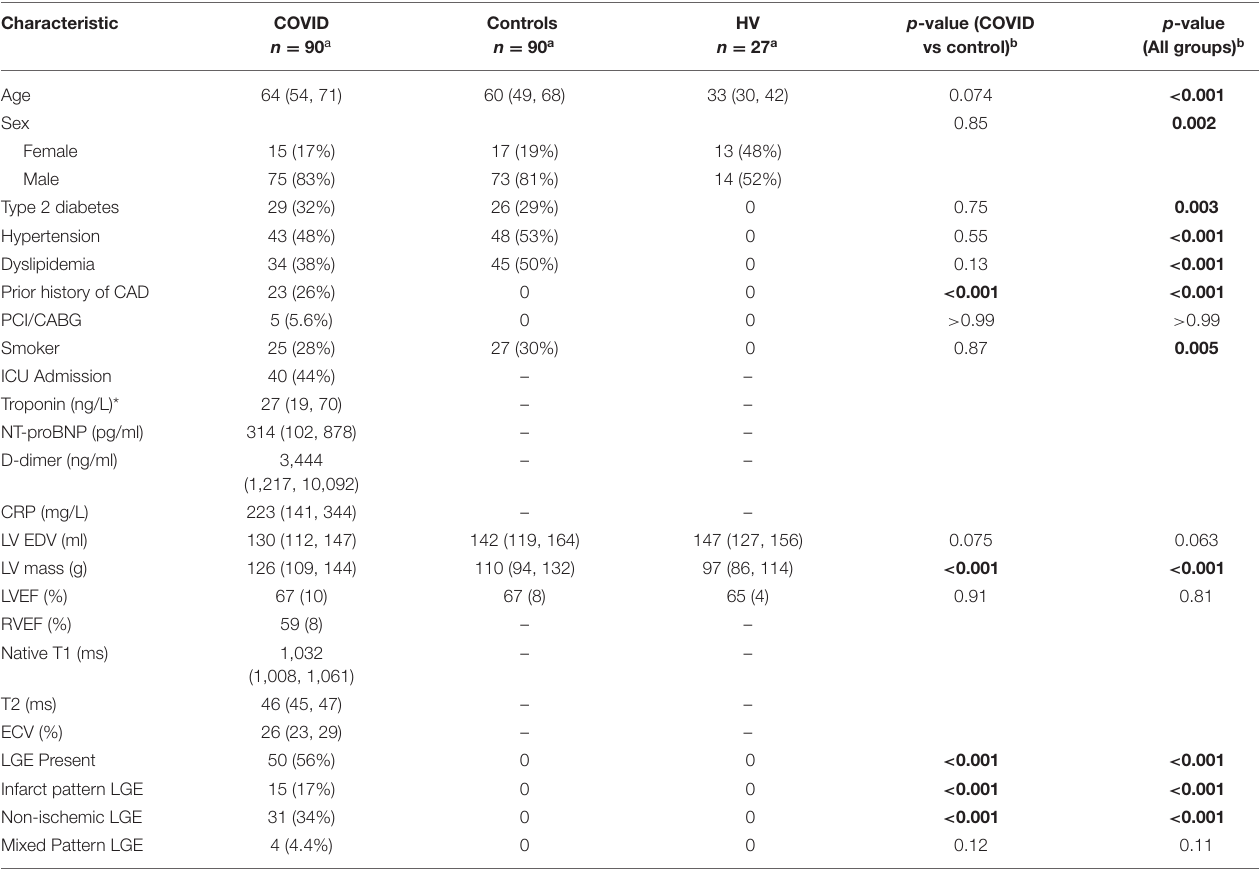
TABLE 1 | Baseline